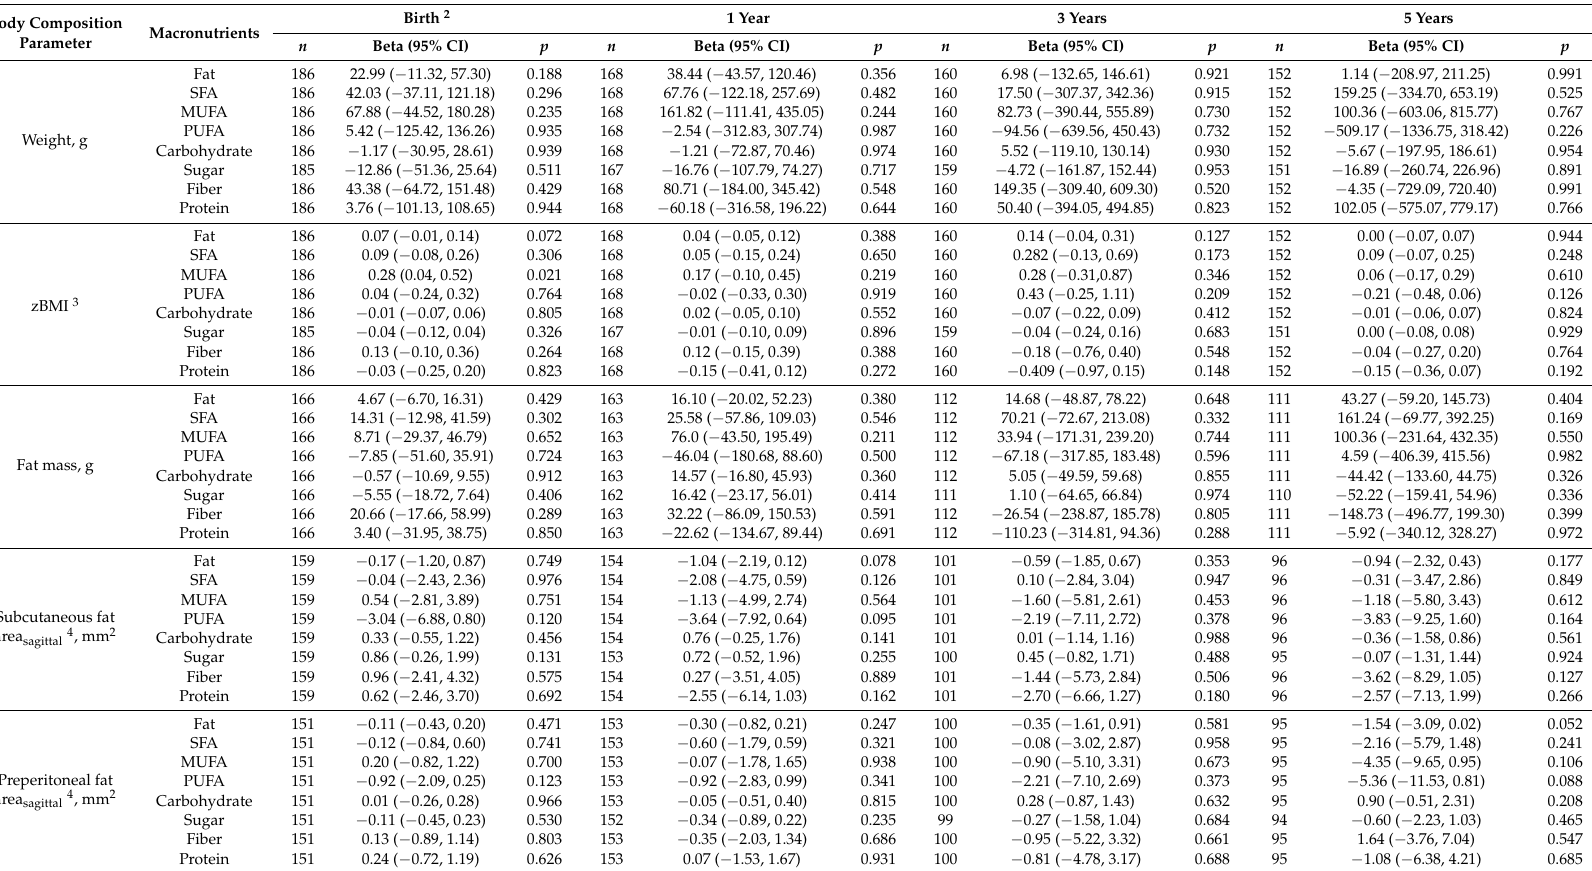
Table 3. Partition model from early gestation (15th week of gestation) at birth, 1 year, 3 years, and 5 years 1